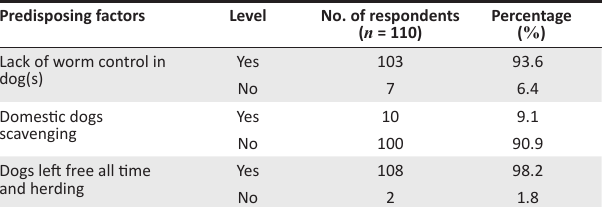
TABLE 3: Predisposing factors for Taenia spp. infection in dogs in the Ngorongoro district. Predisposing